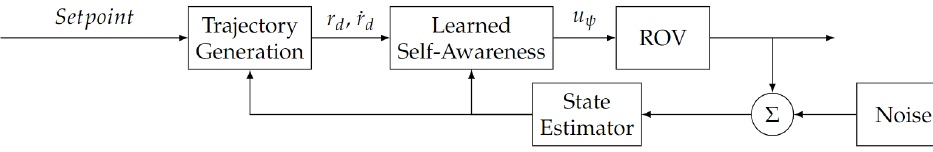
Figure 4. Deterministic artificial intelligence